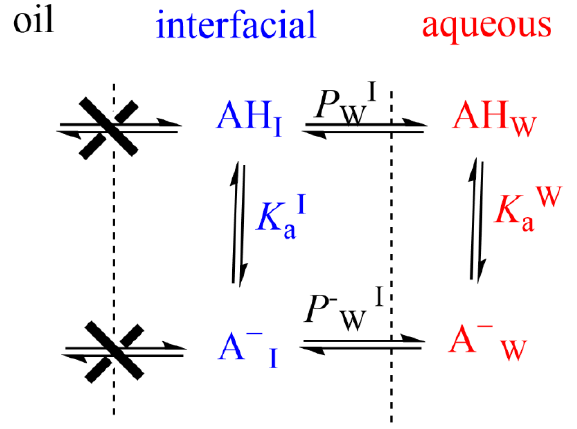
Figure 10. An illustrative representation of the distribution of an oil insoluble carboxylic antioxidant (AH) between different regions of an emulsified system. P WI and P –WI stand for the partition constants for the neutral and ionized species of the carboxylic antioxidant.